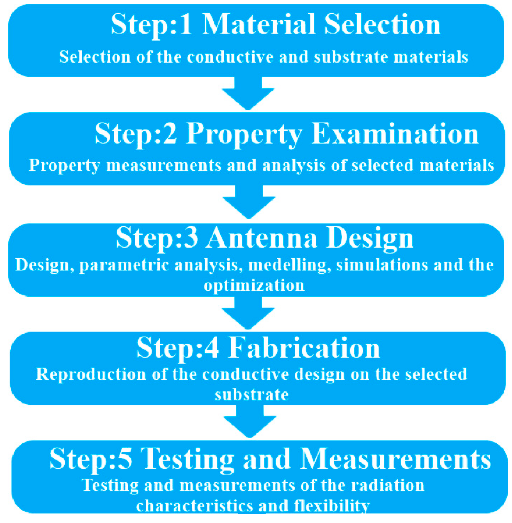
Figure 3. Five steps in the design procedure for a flexible substrate antenna.